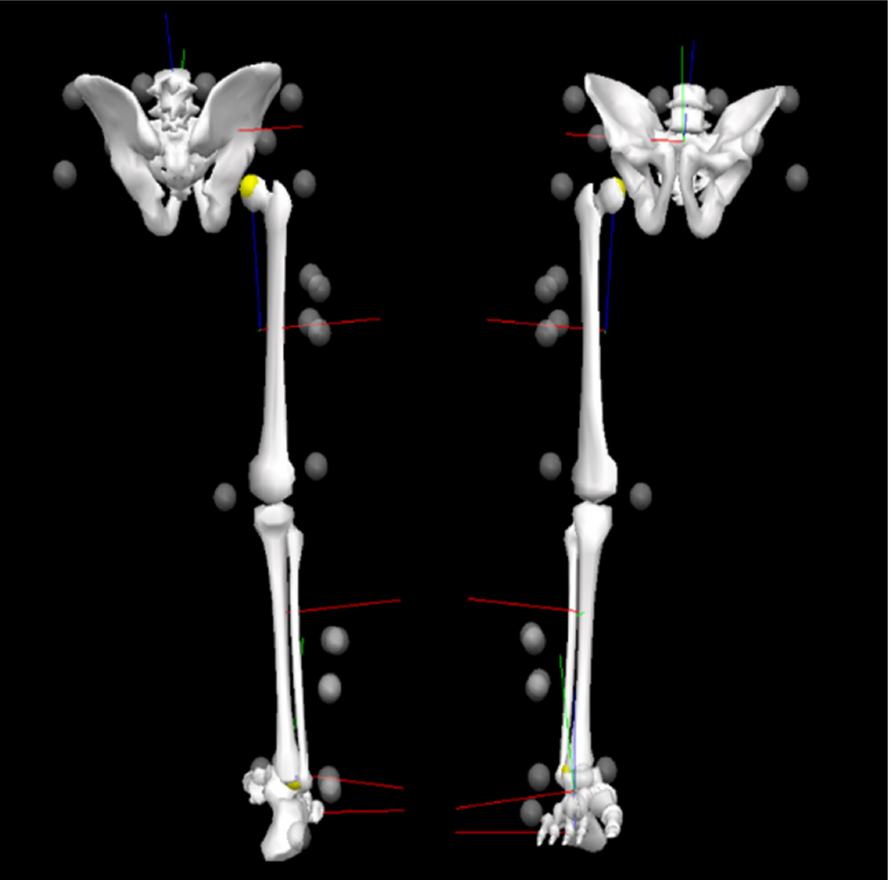
Figure 1. Attachment of markers on lower extremity (the axis of angular displacement and velocity were defined as Figure 2, red line = positive x -axis vector, green line = positive y -axis vector, blue line = positive z -axis vector, white circle = attachment of marker).